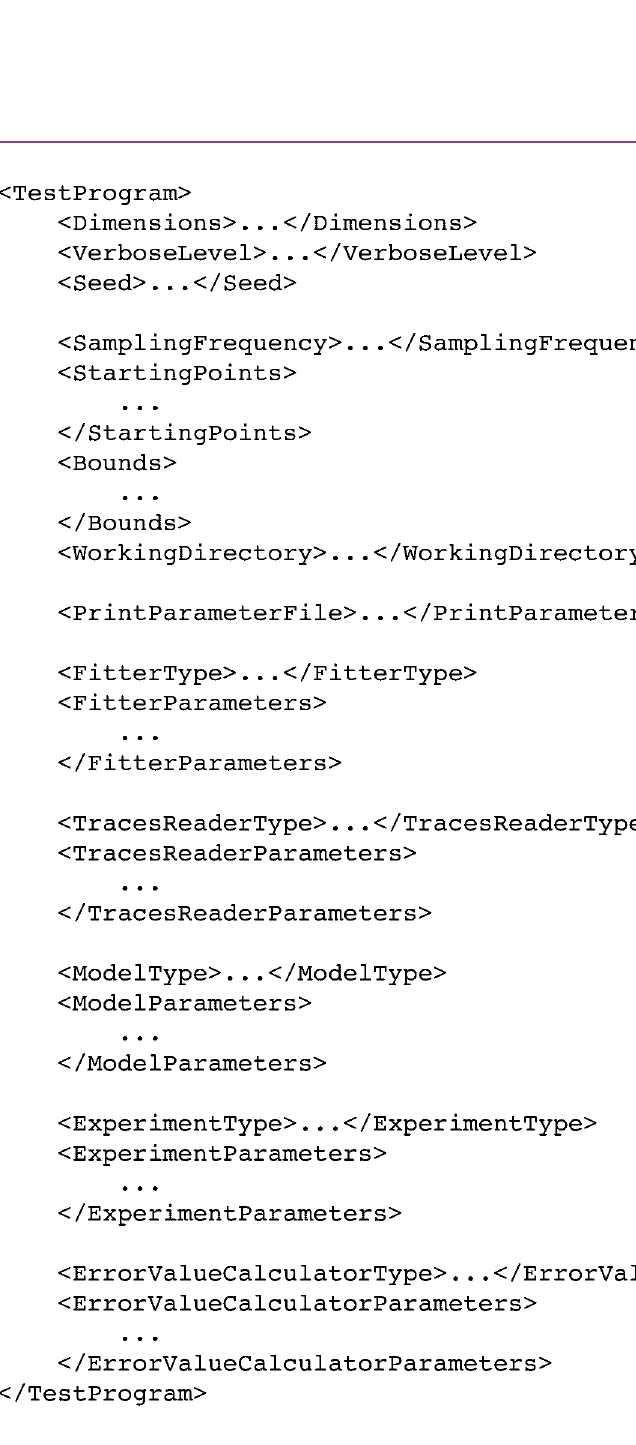
Figure 4. XML structure . The basic structure of the XML settings file. The root tag can be chosen by the user. A more extended example can be found in Appendix B.